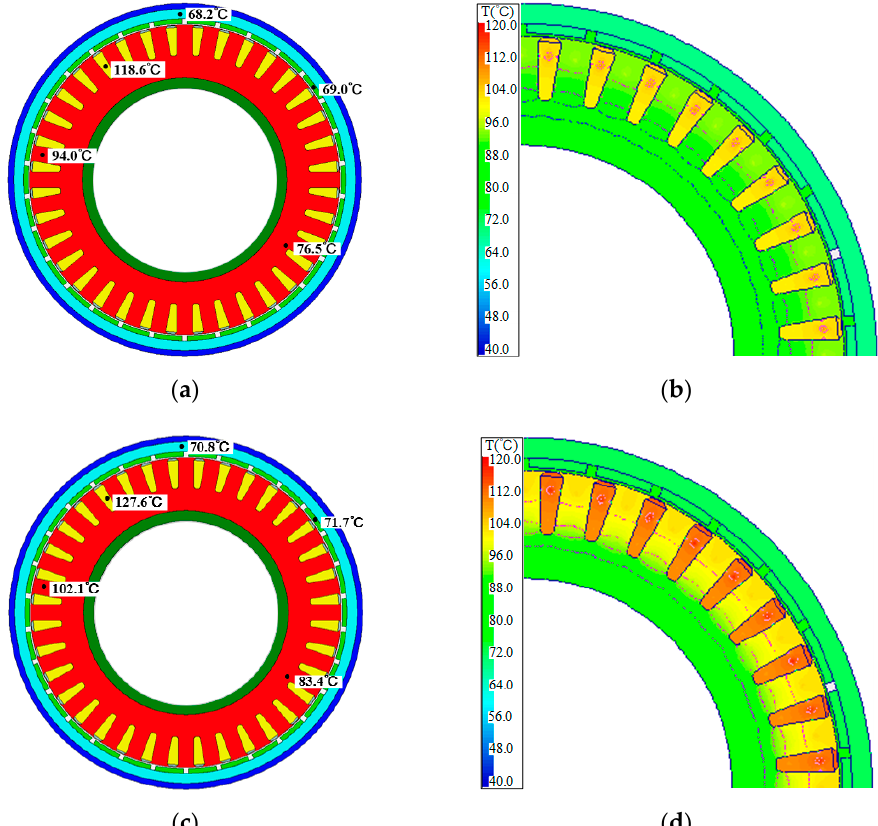
Figure 9. Temperature distributions under 1.2 T and 1.6 T: ( a ) whole temperature distribution under 1.2 T; ( b ) partial temperature distribution under 1.2 T; ( c ) whole temperature distribution under 1.6 T; ( d ) partial temperature distribution under 1.6 T.